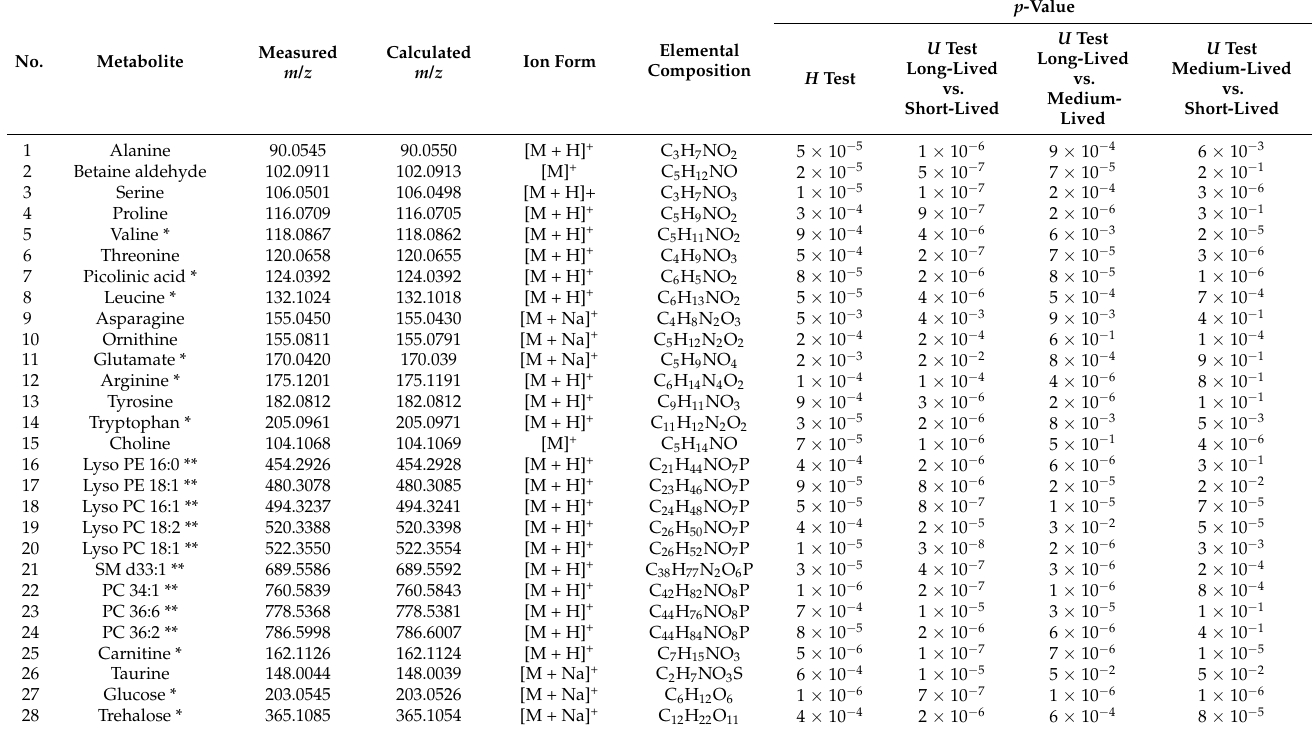
Table 1. List of the significantly different ( p ≤ 0.01) metabolites between the cohorts of fly